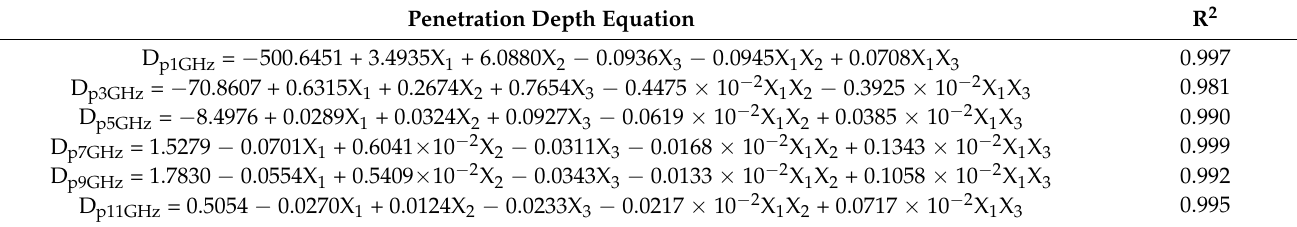
Table 5. Regression equations for the penetration depth (D p ) of the porous nHA/S composites at 1, 3, 5, 7, 9, and 11